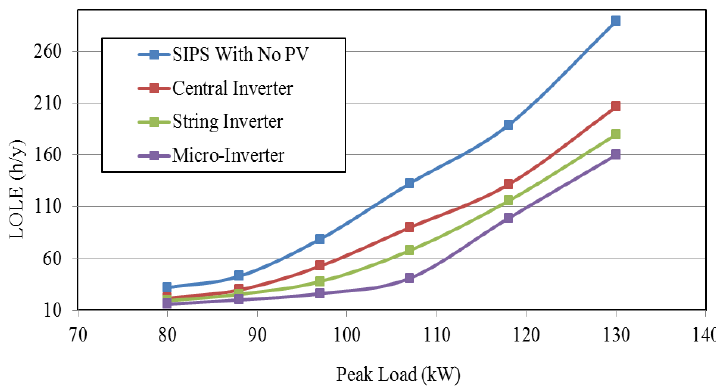
Figure 12. Variation in risk level (LOLE) with system demand load for different PV topologies.